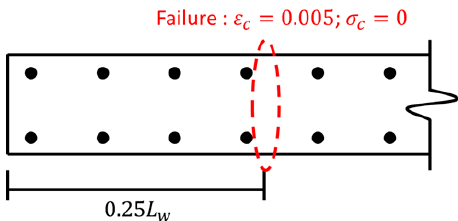
Figure 12. Concrete crushing in unconfined wall.